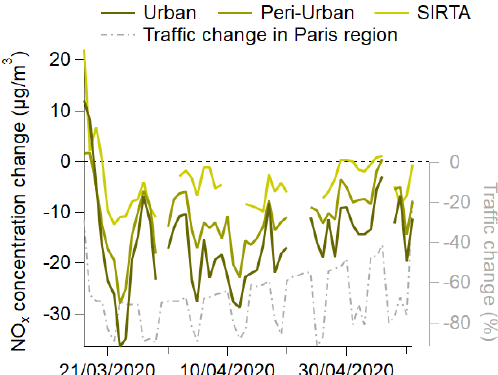
Figure 5. Temporal variation of NO x concentration changes at SIRTA and urban and peri-urban background stations of the Paris